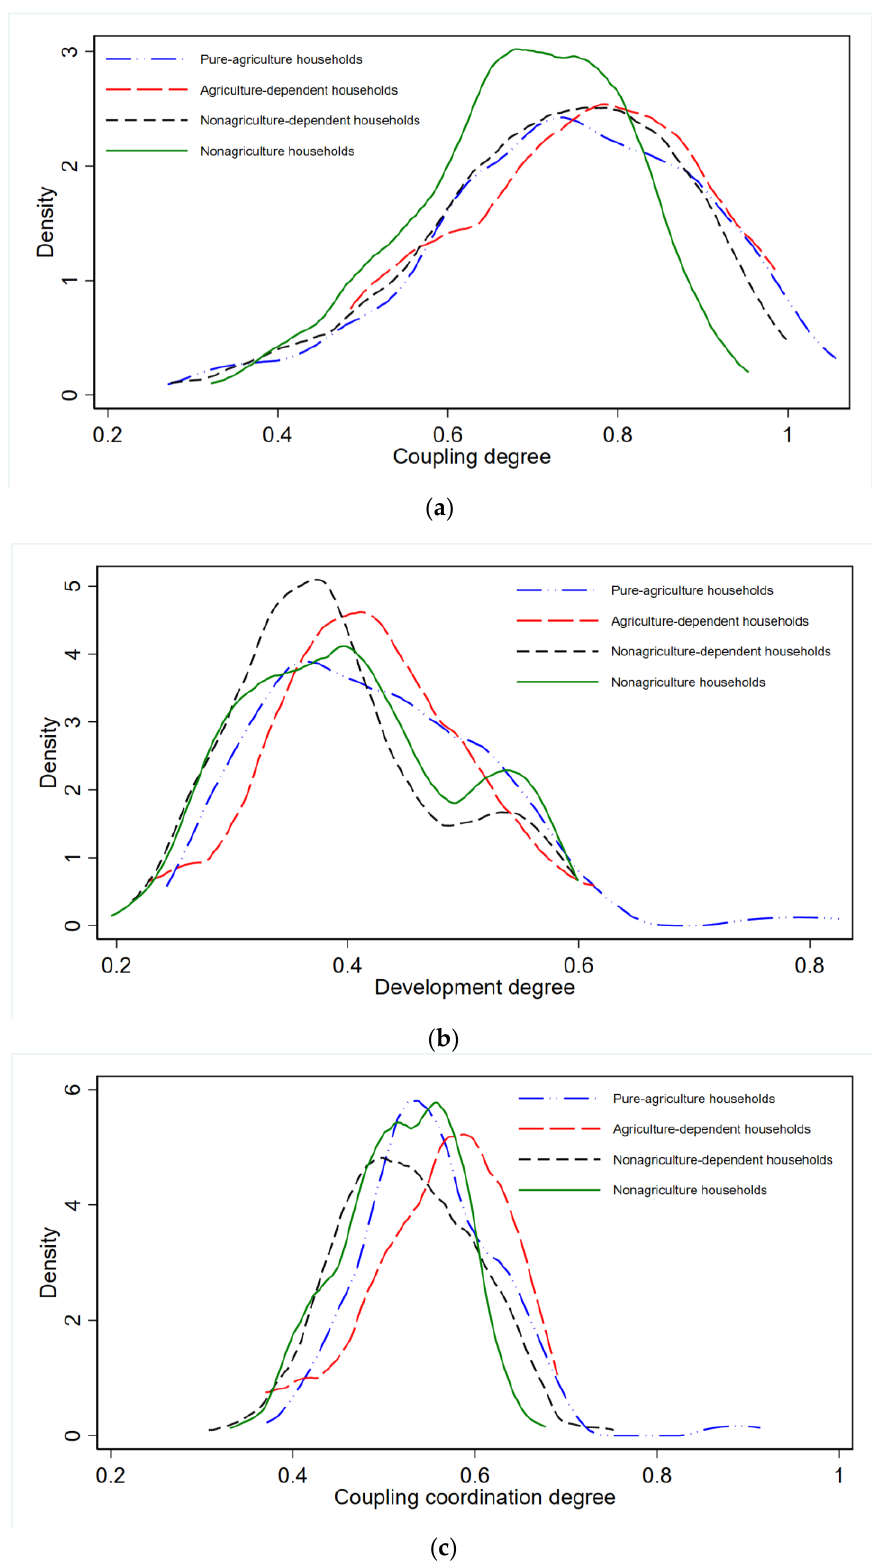
Figure 2. Kernel density estimation diagram of the coupling coordination relationship between livelihood efficiency and land use of different types of households. Coupling degree ( a ), development degree ( b ), coupling coordination degree ( c ).